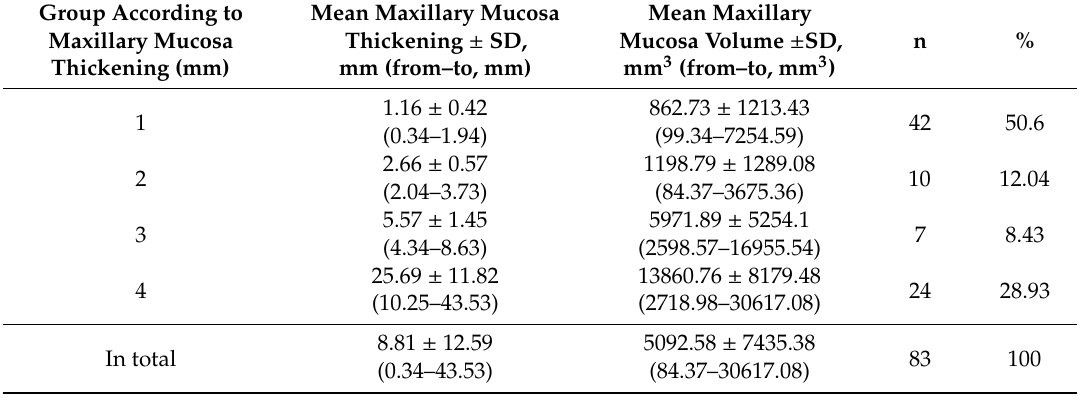
Table 3. The detailed analysis of MMV (mm 3 ) according to the mucosa thickening group (mm).